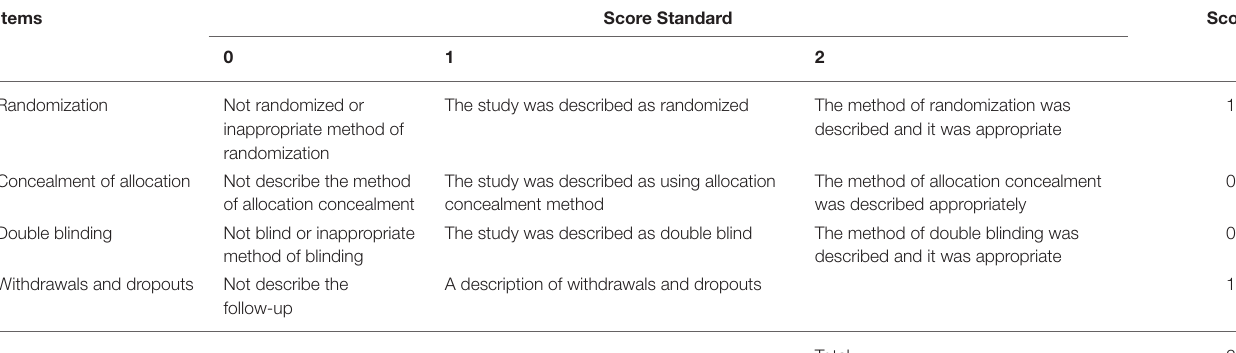
TABLE 4 | Modified Jadad Score for < Clinical efficacy of 0.01% atropine in retarding the progression of myopia in children > .